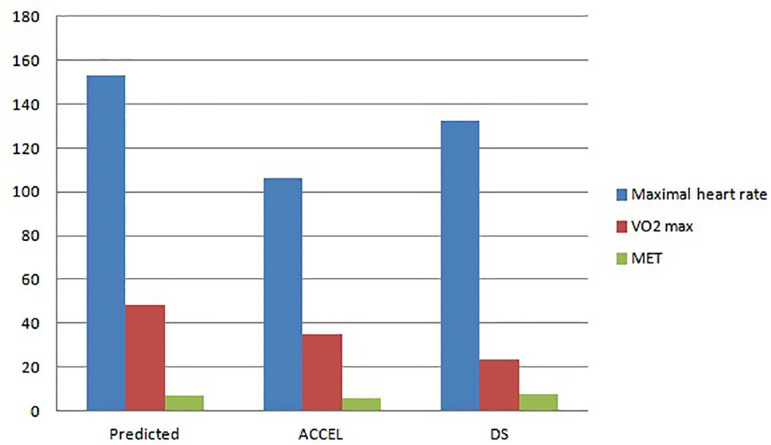
Averages obtained in the erogoespirometry test.ACCEL=Accelerometer; MET=Metabolic equivalent; DS=Double Sensor